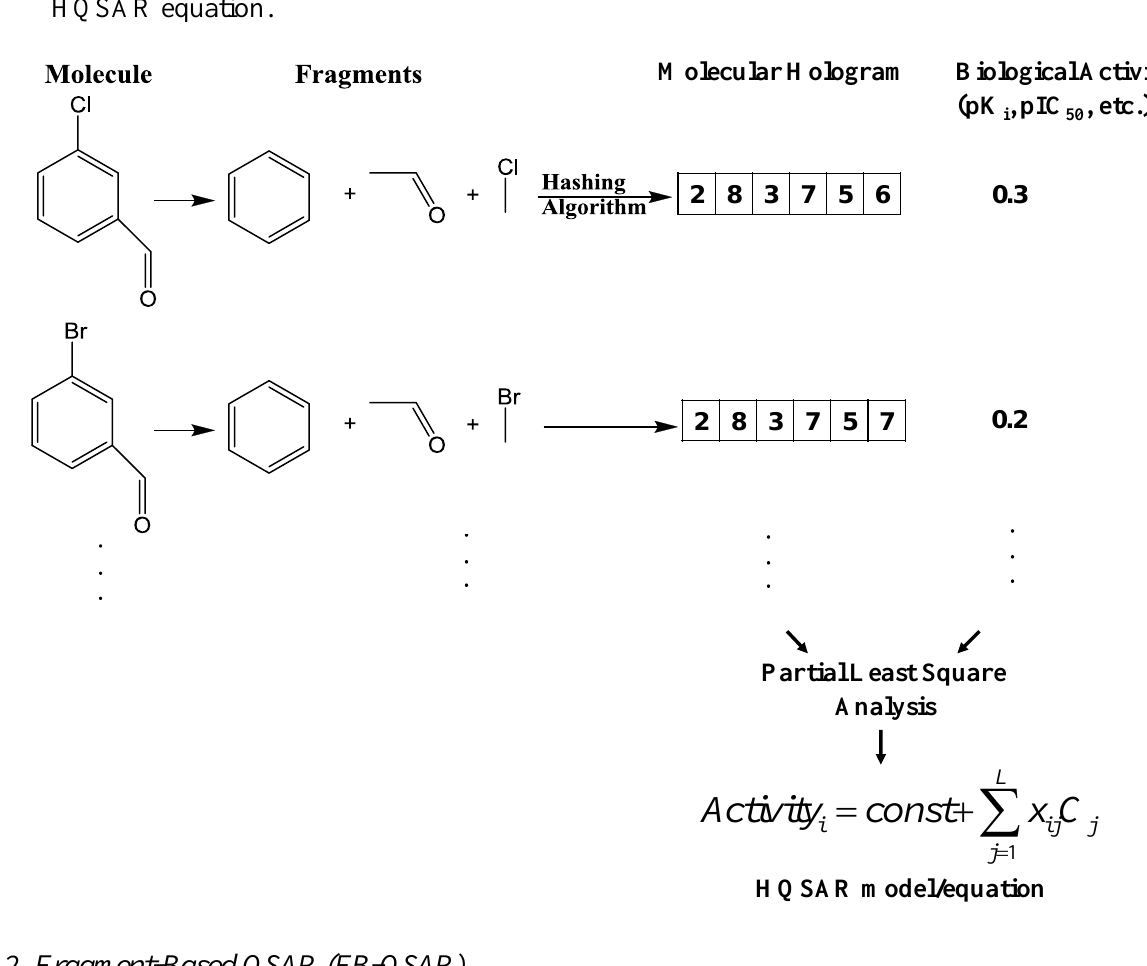
Figure 2. Hologram-QSAR (HQSAR) model development, which includes molecular hologram generation and partial least square analysis to derive a final predictive HQSAR equation.